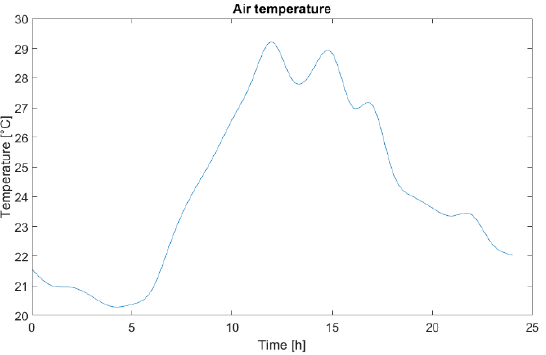
Figure 5: Air temperatures used for the simulation.